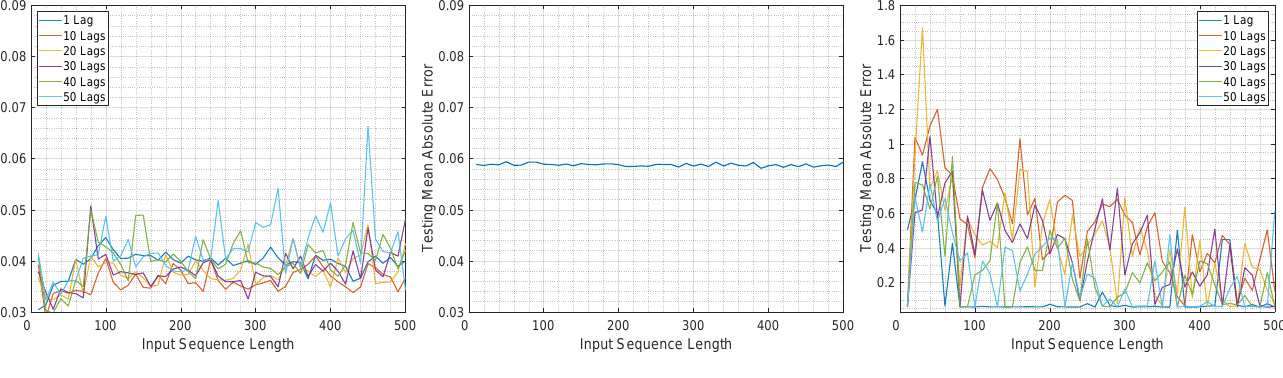
Figure 4. Illustration of the testing mean absolute error value for Experiment 1, LSTMTF ( left ), VLSTM ( middle ), and LSTMTFC ( right ), using a many-to-many prediction mode. The same behavior was observed in terms of testing error standard deviation values, with values in the range of [0.037, 0.042] for LSTMTF for input sequence lengths in the range of [1, 100] and [0.0435, 0.046] for VLSTM for all input sequence